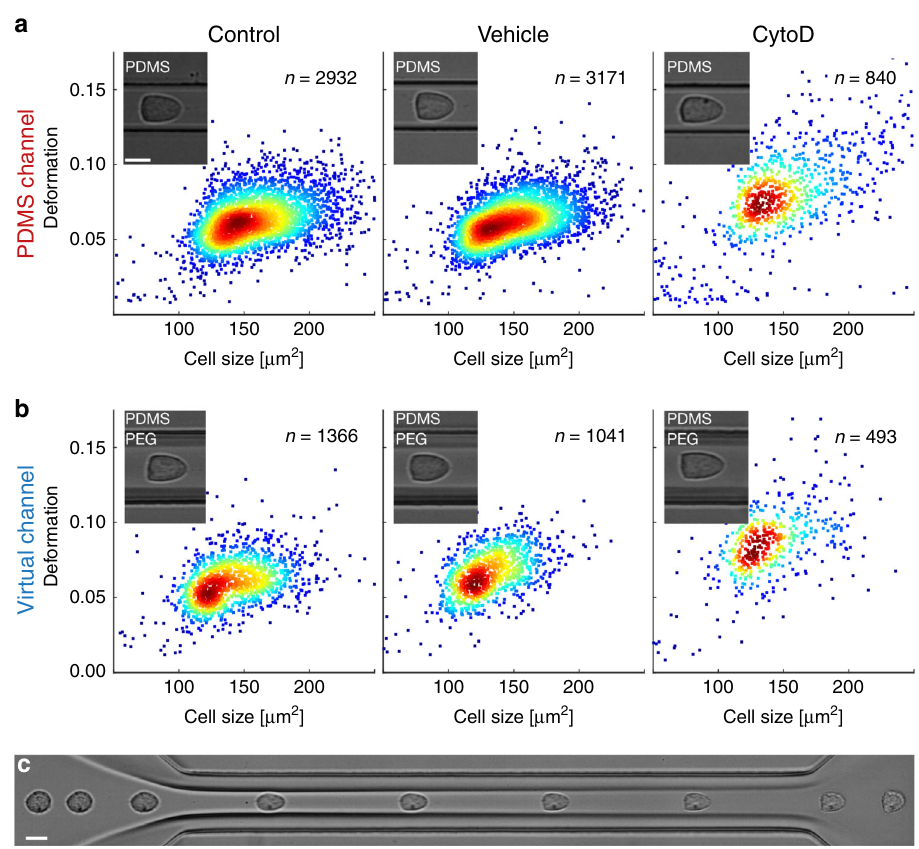
Fig. 2 Cell deformation in PDMS chip and virtual fl uidic channel. a Real-time deformability cytometry (RT-DC) of HL60 cells in polydimethylsiloxane (PDMS) channel yielding scatter plots of deformation versus cell size for control cells (left), dimethyl sulfoxide (DMSO) vehicle control (0.25% (v/v), center) and 1 µ M CytoD (right). Measurements have been done at a total fl ow rate of 40 nl s − 1 in a PDMS chip with a 300 µ m long channel and 20 µ m × 20 µ m squared cross-section using 57 µ M MC for sample and sheath buffer, respectively. b RT-DC of HL60 cells in a virtual channel of 21 µ m width and 30 µ m height for control cells (left), DMSO vehicle control (0.25% (v/v), center) and 1 µ M CytoD (right). Virtual channel is formed inside a PDMS chip with a 300 µ m long channel and 30 µ m × 30 µ m squared cross-section using 57 µ M MC (sample) as well as 50 mM PEG8000 (sheath). Measurements are taken at indicated position (Fig. 1a, gray rectangle) and a total fl ow rate of 94 nl s − 1 ( Q sa = 90 nl s − 1 , Q sh = 4 nl s − 1 ). Insets show representative cell images. c Time series of single HL60 cell passing a virtual channel (sample 57 µ M MC, Q sa = 72 nl s − 1 , sheath 50 mM PEG8000, Q sh = 8 nl s − 1 ). Average cell velocity within the channel is ~20 cm s − 1 . Scale bar is 10 µ m. Recording of time series has been repeated fi ve times. Color in scatter plots indicates a linear density scale from min (blue) to max virtual channel is always aligned in the center of the constriction (Fig. 1a) con fi ning the cells perpendicular to one direction of fl ow only and leaving the channel height of 30 µm unaltered (Fig. 1a, bottom inset).